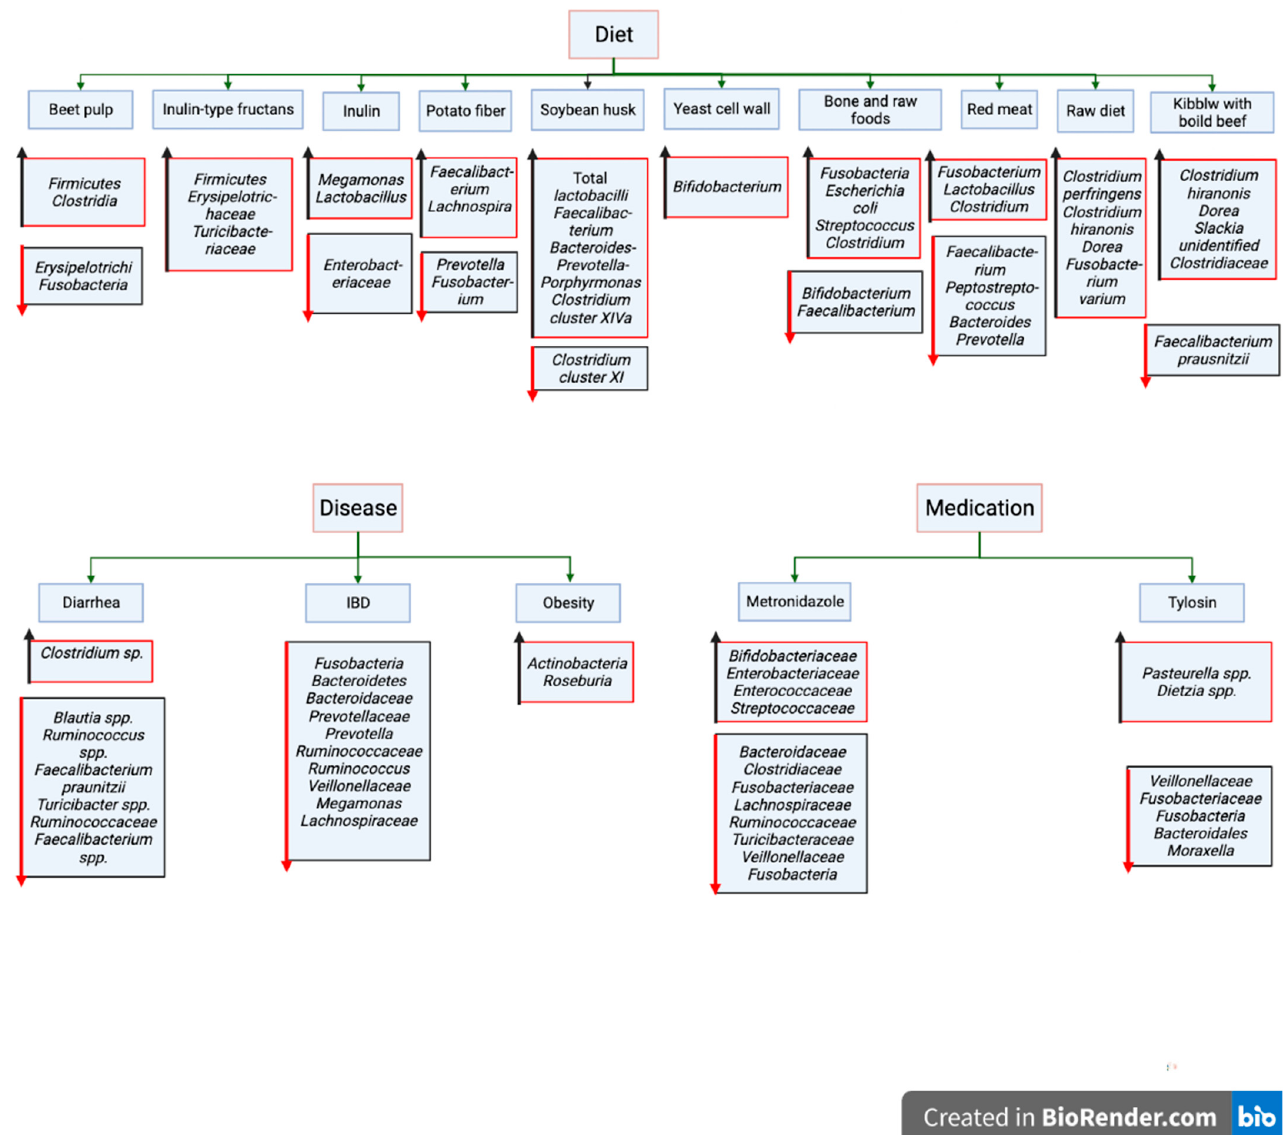
Figure 1. Major influencing factors of canine gut microbiota. (Arrows: upward, increased relative abundance; downward, decreased relative abundance). (Created with BioRender.com, accessed date 18 June